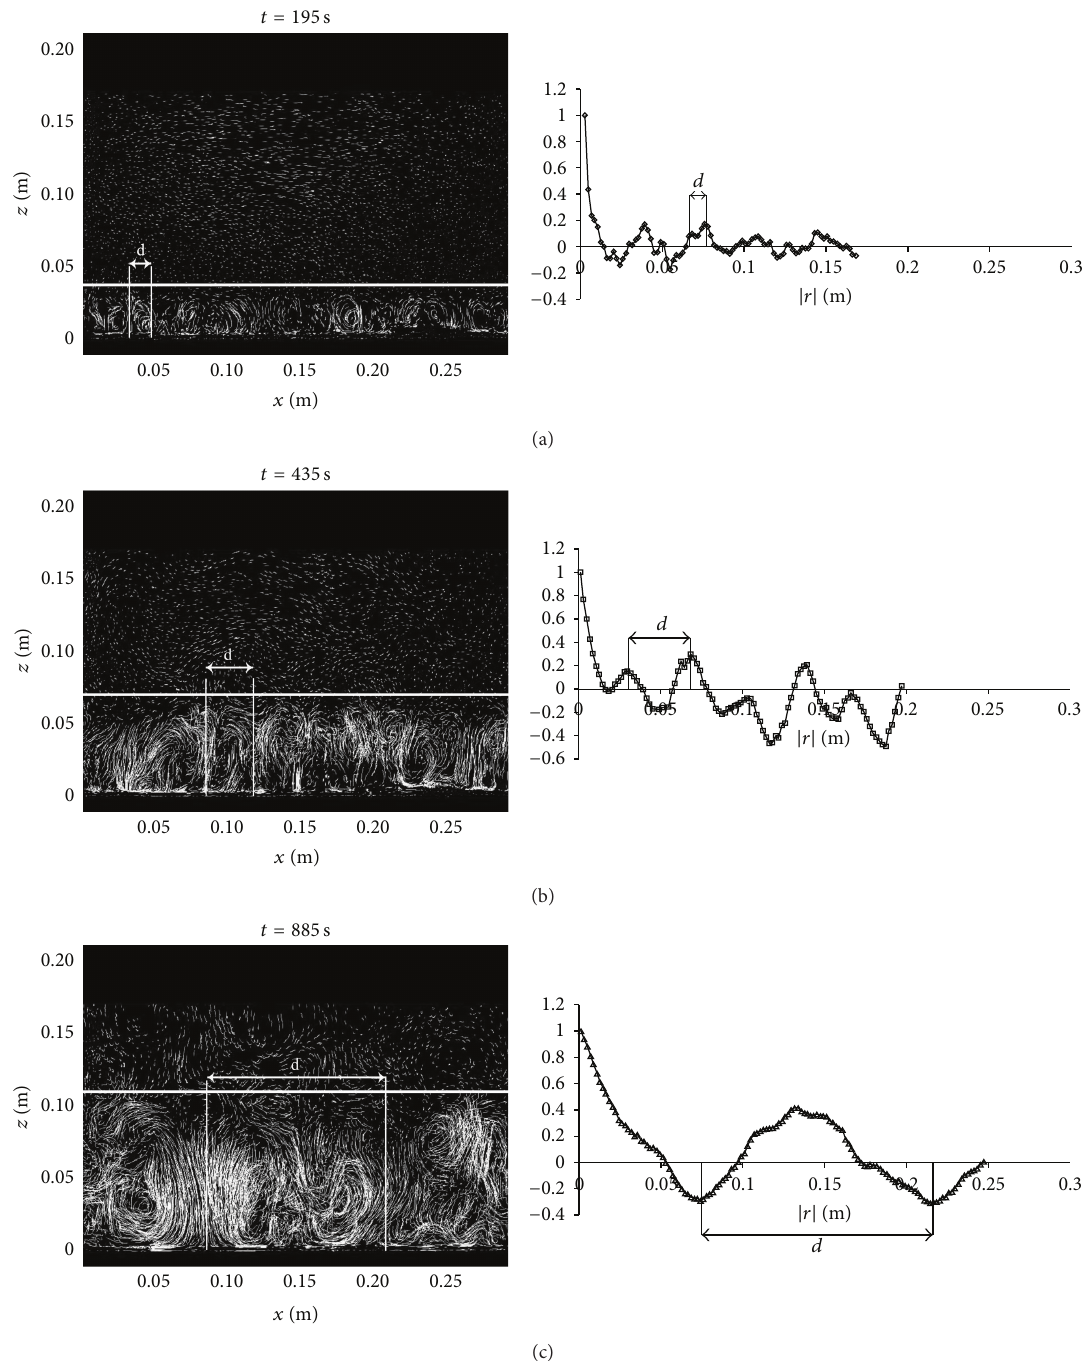
Figure 13: Spatial autocorrelation of the vertical component of the velocity field for three times (experiment A2).